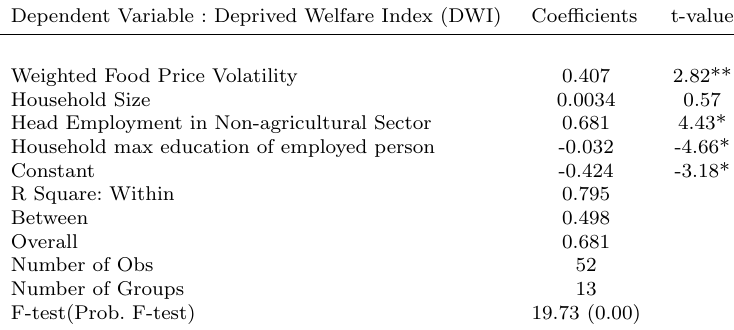
Table 2: Results of